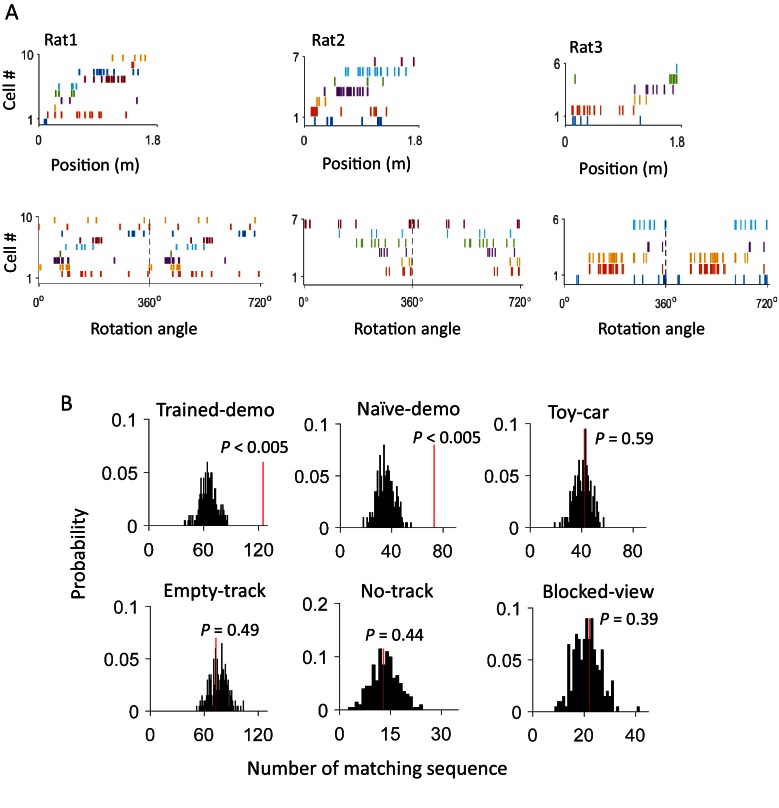
Firing sequences of multiple common cells were cross-activated between rotation events in the box and lap-running events on the track.(A) Firing sequences of 3 example sets of common cells (Rat1 - Rat3), each from a different rat. For each example, the sequence during a running lap on a trajectory of the track was on the top and that of the same set of cells during a rotation event in Post-box was on the bottom. Each row is the spike raster of one cell. Cells were ordered by peak firing locations on the track. A full cycles (360°) were plotted twice for each rotation event. Note that the sequences on the track matched the rotation sequence with the same (Rat1, Rat3) or opposite (Rat2) order. (B) Actual number of matching sequences (red line) relative to the distribution of randomly-generated number of matches (black histogram) under each box condition. P: significance p-values.